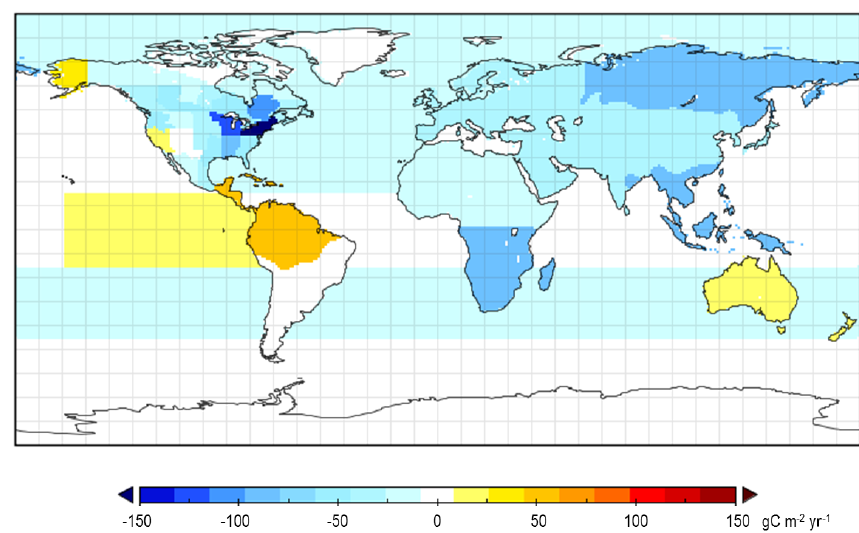
Figure 8. Global distribution of inverted CO 2 flux using CO 2 data only (2002–2004 average).